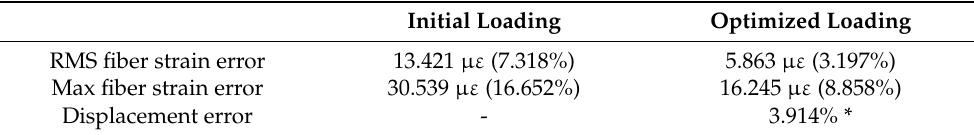
Figure 17. Fiber strain distribution from inverse calculation. Table 4. Fiber strain error statistics of uniform loading and optimized loading (inverse calculation); * average displacement.